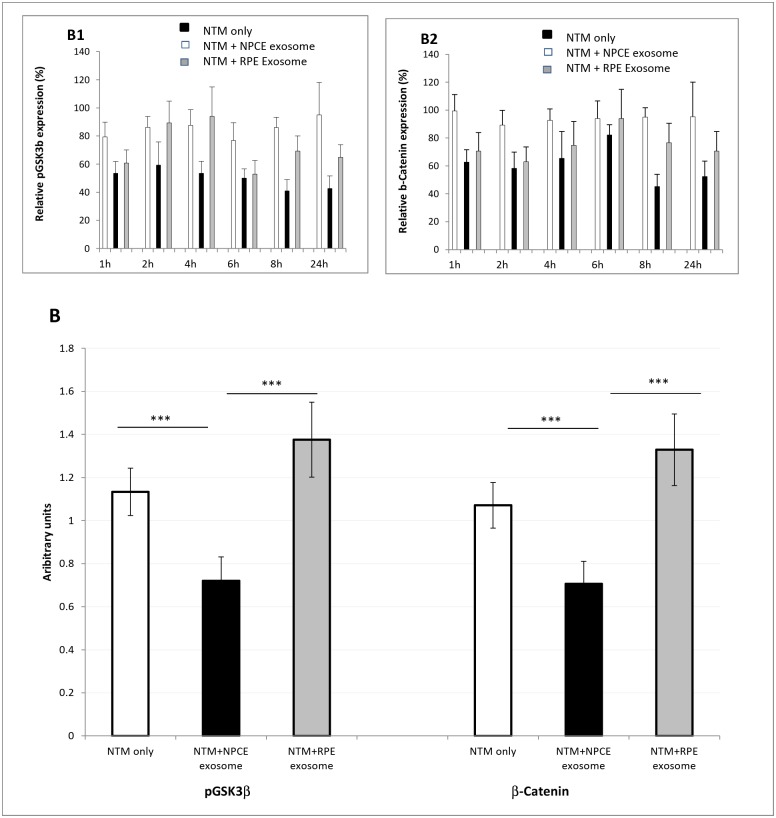
Effect of NPCE-derived exosome treatment on the Wnt signaling pathway in NTM cells.Lysates from NTM cells untreated or exposed to NPCE-derived exosomes or RPE derived exosomes were subjected to immunoblot analysis to detect cytosolic β-catenin or phospho-GSK3β. β-actin was used as a loading control. Data represent means ± S.D from minimum three independent experiments. (A) A representative Western blot showing expression of β-catenin (A1) and phospho-GSK3β (A2) at various time points. (B) Histograms presenting mean interaction of the phospho-GSK3β and β-catenin expression. ***P<0.001. (B1 & B2 inserts) A time and treatment histogram chart of the relative expression of β-catenin and phospho-GSK3β.